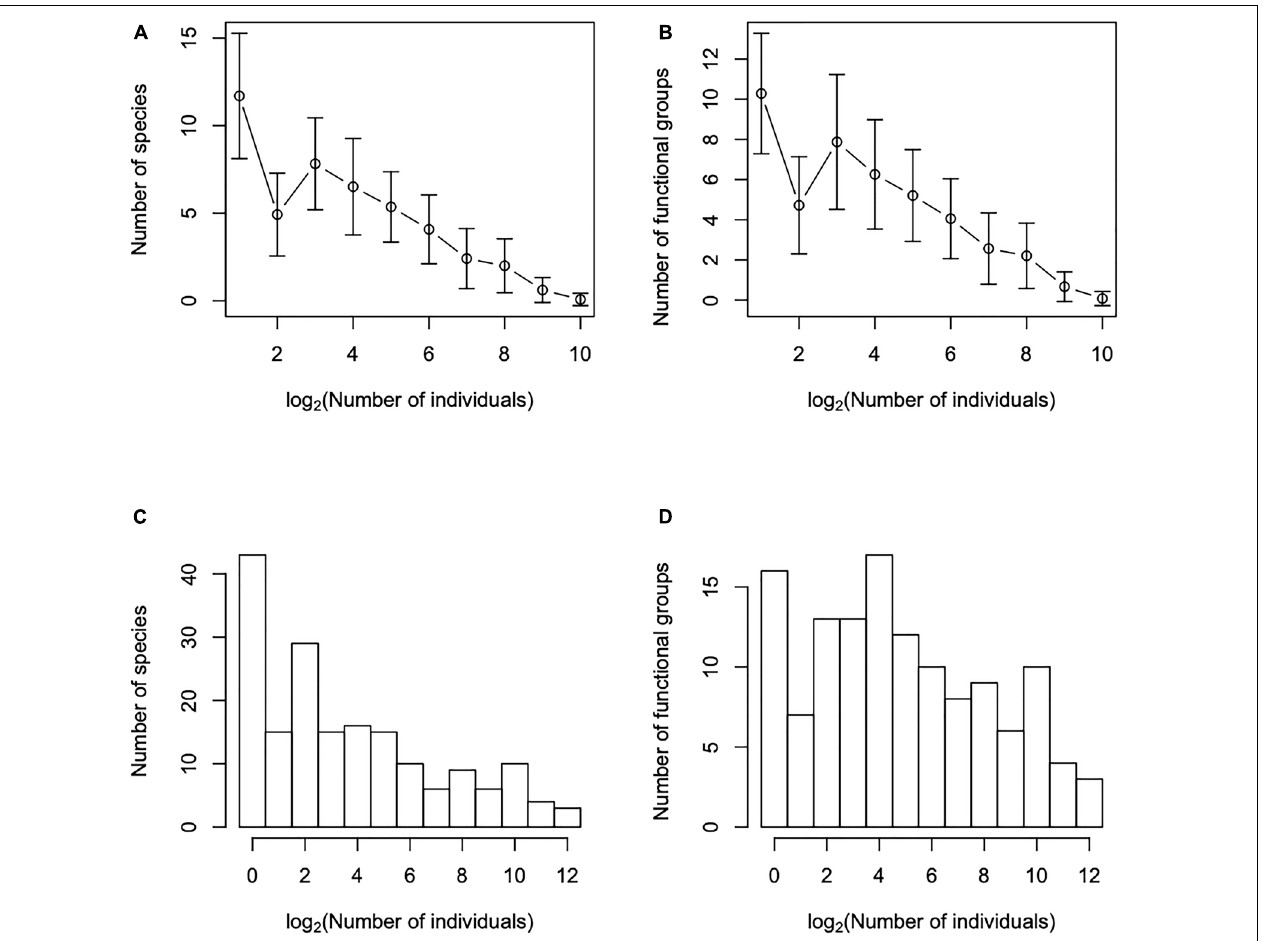
FIGURE 2 | Species abundance distributions, plots (A,C) , and functional units abundance distributions, plots (B,D) ; functional units are the functional entities obtained by aggregating species with the same trait combinations. Plots (A,B) are obtained after averaging the abundance distributions of all transects and the bars correspond to two standard deviations, while plots (C,D) are obtained after adding all transects. Notice that the shape of the distributions changed when we consider the average of all transects and when we all add all